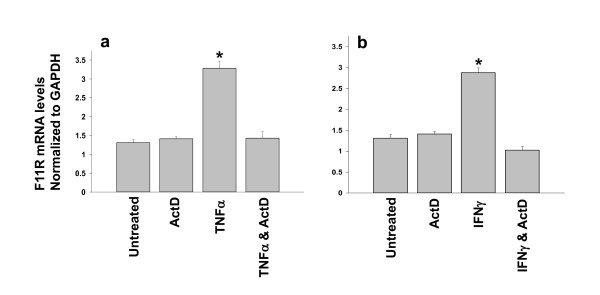
De novo expression of F11R mRNA in inflamed endothelial cells: blockade of F11R mRNA expression in endothelial cells treated with TNFα and IFNγ by the RNA synthesis inhibitor, actinomycin. Confluent monolayers of HUVEC were maintained under Untreated conditions, or pretreated with the RNA synthesis inhibitor, actinomycin D (ActD) (5 μg/mL), in growth supplement-free media for 1 hr at 37°C. The response of HUVEC maintained in the presence of ActD alone is shown in histogram labeled ActD. The response of HUVEC treated with TNFα alone(100 u/ml) is shown in Figure 3a, and the response of HUVEC treated with IFNγ alone(200 u/ml) for 24 hrs is shown in Figure 3b. The response of HUVEC pretreated with ActD prior to 24 hr exposure to either TNFα (100 u/mL) or IFNγ (200 u/mL), is shown in the histograms labeled TNFα & ActD (see Figure 3a) or IFNγ & ActD (see Figure 3b). The F11R mRNA levels were measured by Real-Time PCR in triplicate for each condition. Values are the mean ± SEM. * P < 0.05 significant differences in F11R mRNA observed between cells exposed to TNFα or IFNγ alone vs ECs treated (or not treated) with ActD alone or ECs treated with ActD followed by their exposure to either TNFα or IFNγ.